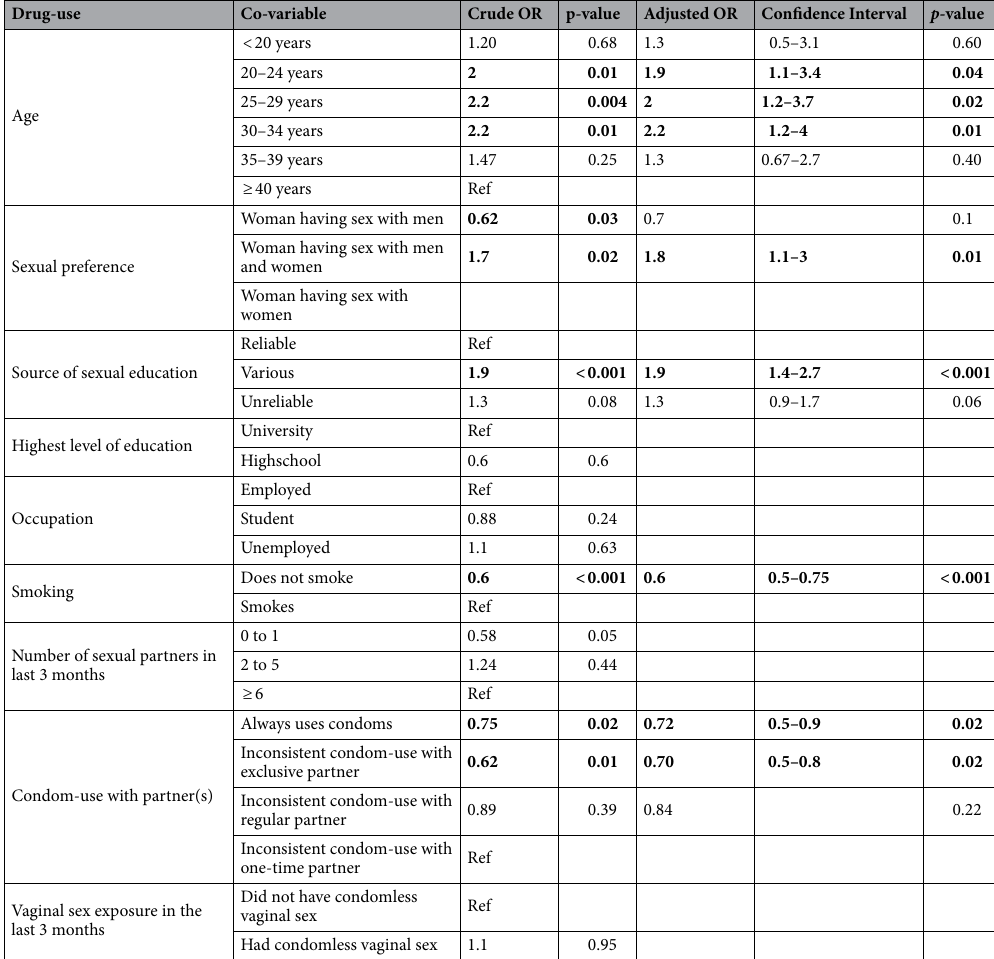
Table 6. Binomial regression model for recreational drug-use with crude and adjusted odds ratios (ORs). Significant results are in